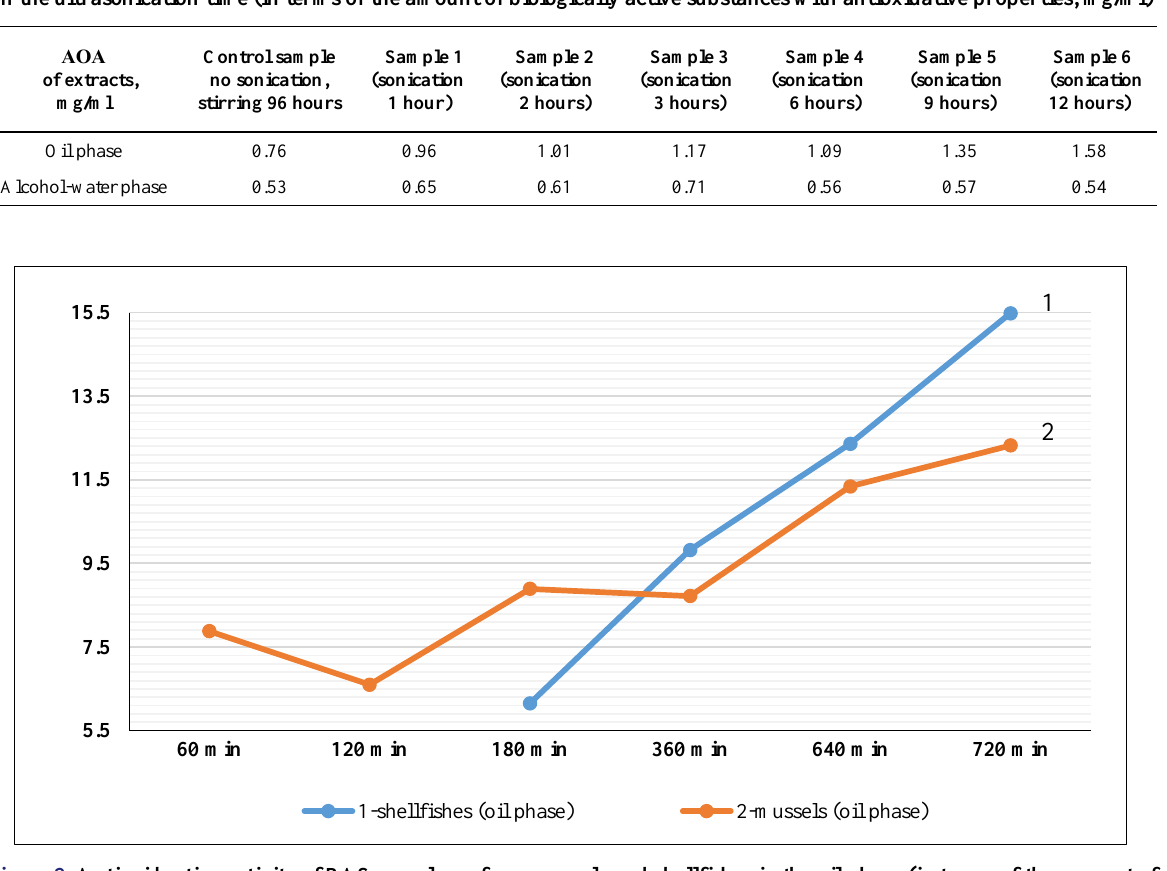
Figure 2 . Antioxidantive activity of BAS complexes from mussels and shellfishes in the oil phase (in terms of the amount of biologically active substances with antioxidative properties, mg/g).